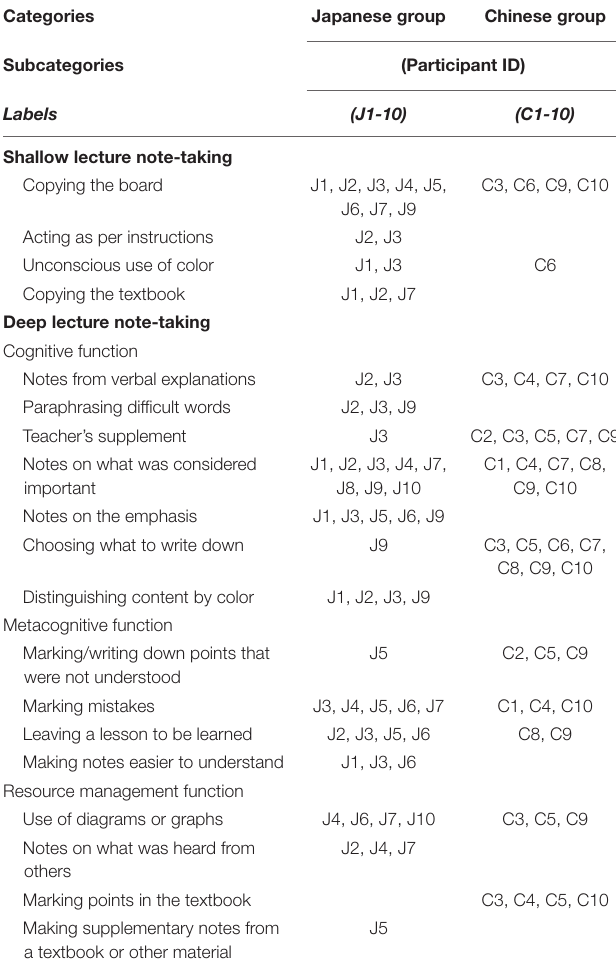
TABLE 3 | Comparing the note-taking classifications between the two